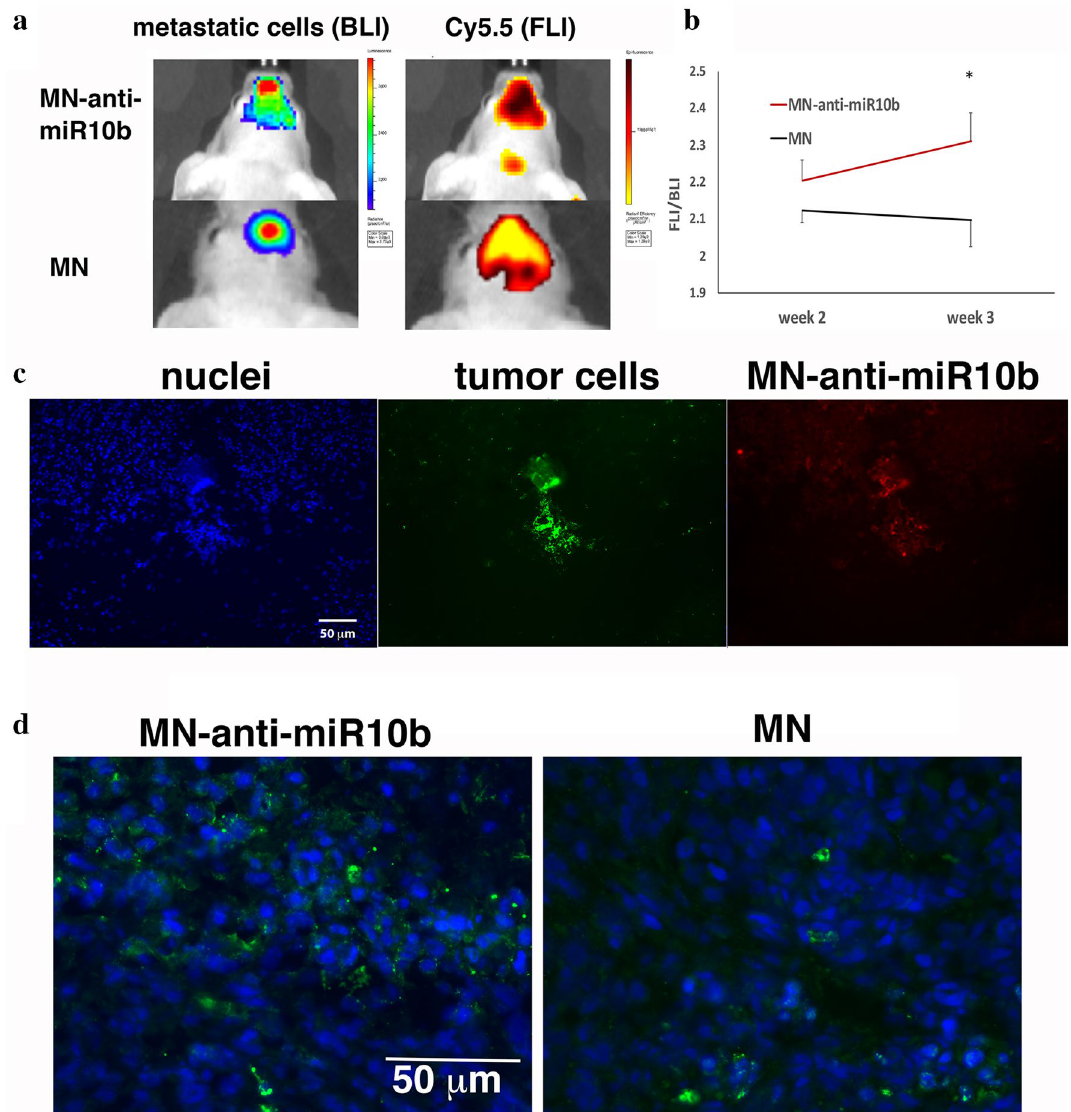
Figure 2. Delivery of MN-anti-miR10b to brain metastases from breast cancer. ( a ) In vivo bioluminescence (metastatic cells) and Cy5.5 fluorescence (MN-anti-miR10b) images over the brain of a mouse treated with MN-anti-miR10b obtained 24 h. after injection of the nanotherapeutic. Bioluminescence and Cy5.5 fluorescence co-localized indicating selective accumulation of MN-anti-miR10b in the metastatic lesions. ( b ) Ratio of fluorescence intensity (FLI: Relative Fluorescence Units, MN-anti-miR10b) to bioluminescence (BLI: photons/sec, metastatic burden) indicating that MN-anti-miR10b accumulation increased in the brain lesions with treatment, which was not observed in the MN-treated controls. ( c ) Fluorescence microscopy of brain metastatic lesions demonstrating the presence of micrometastases in perivascular regions of the brain and the uptake of MN-anti-miR10b by the micrometastases. ( d ) Fluorescence microscopy of brain metastatic lesions demonstrating upregulation of Homeobox D10 (HoxD10) with treatment and confirming target engagement by the MN-anti-miR10b therapeutic (Pearson correlation; n = 5; p ≤